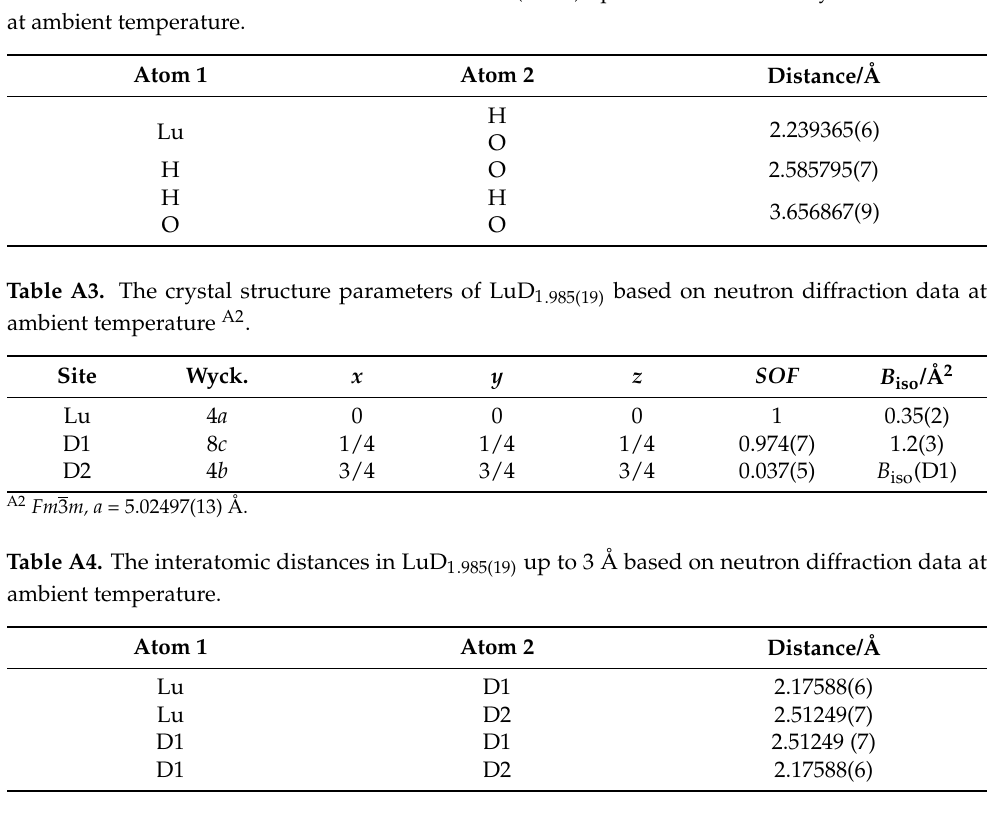
Table A5. Total energies E per number of formula units Z from structure optimizations of the compounds RE 2 O 3 , RE H 3 , RE OF, and RE HO A3